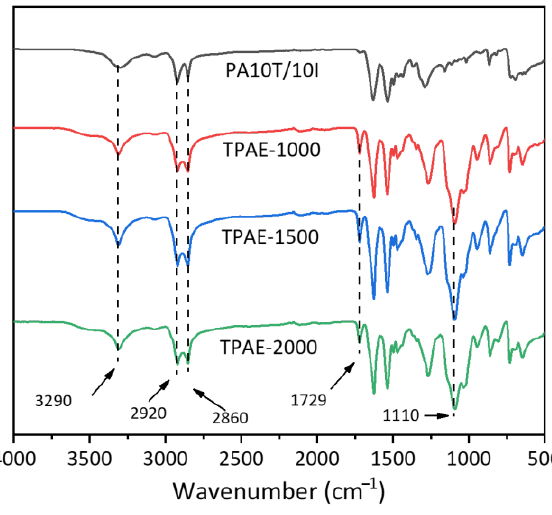
Figure 1. FT-IR spectra of TPAEs and PA10T/10I.